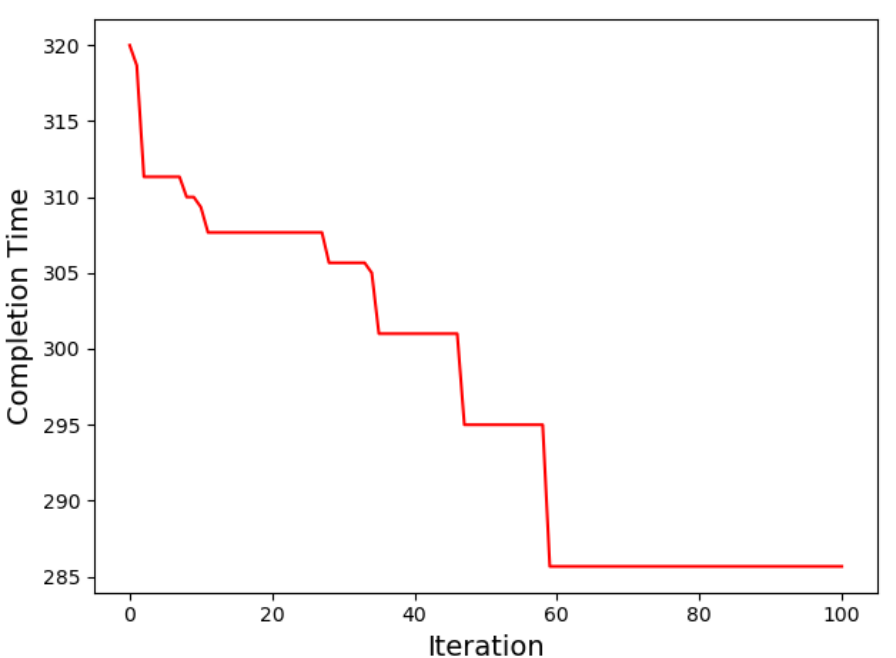
Figure A3. Numerical experiment: YC time–space diagram.